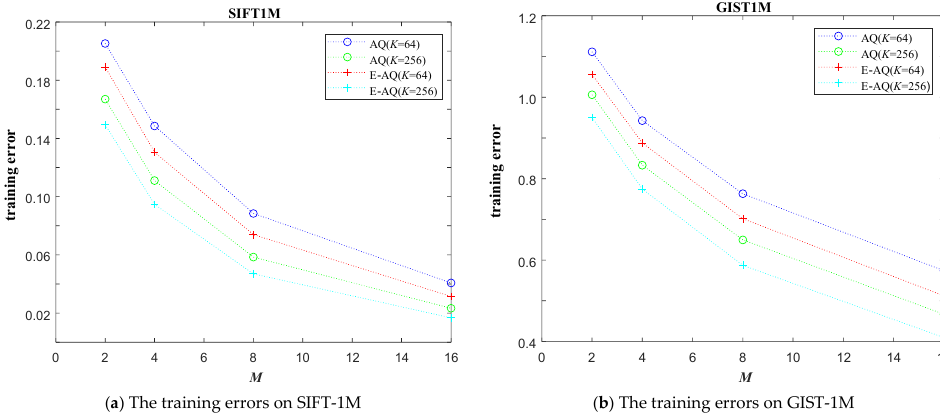
( a ) The training errors on SIFT-1M ( b ) The training errors on GIST-1M Figure 5. The errors produced by training M codebooks on different